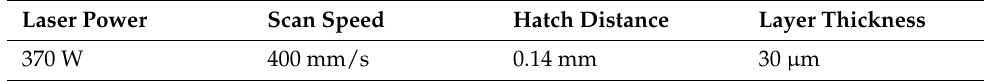
Table 2. L-PBF process parameters used for sample